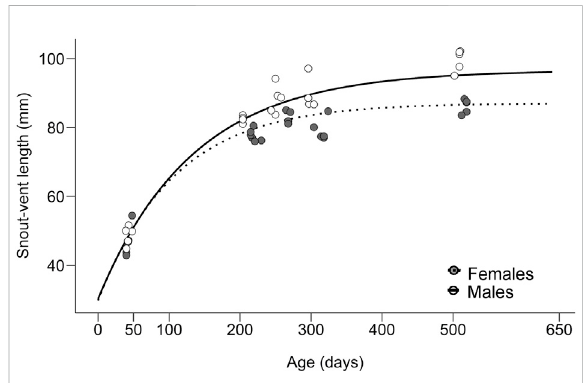
FIGURE 1 Sex-speci fi c growth curves estimated from 256 individuals (data from Kubi č ka et al., 2022.) and snout-vent lengths in males (solid line, white circles) and females (dotted line, grey circles) of Paroedura picta used for gene expression